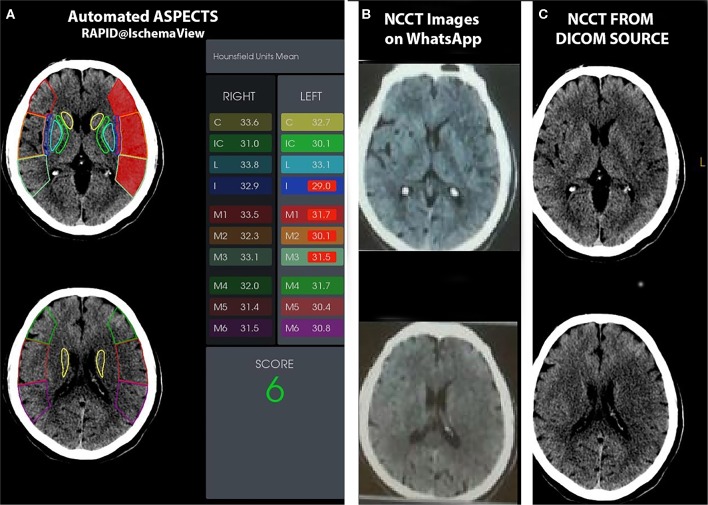
A 70-year-old man who presented with right hemiparesis, dysphasia with right UMN facial weakness, and an NIHSS score of 16. He underwent IV thrombolysis with a door to needle time of 40 min. Automated ASPECTS (A), Axial NCCT images uploaded to the WhatsApp group (B), and axial NCCT images processed by NR on workstation (C) are shown. For the two human readers, one scored 6 and the other 7 (agreement ASPECTS, 6). (B) Automated software assigned an ASPECTS of 6.